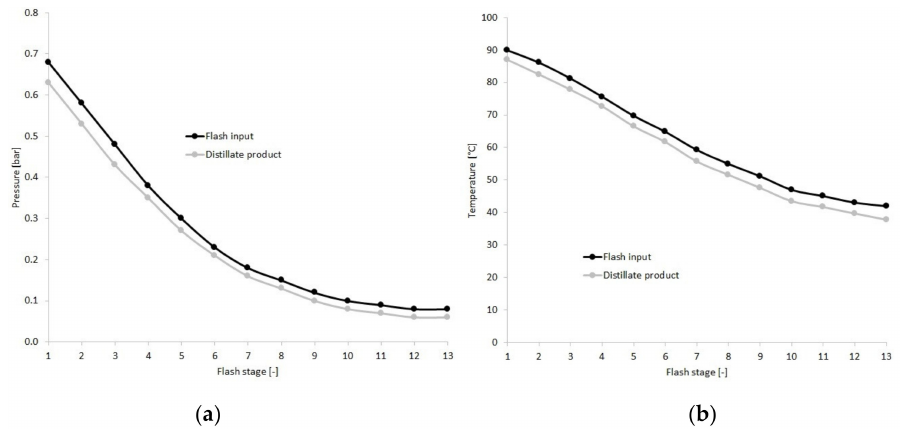
Figure 10. Flash input and distillation product parameters in the function of flash stage. ( a ): pressure, ( b ): temperature.